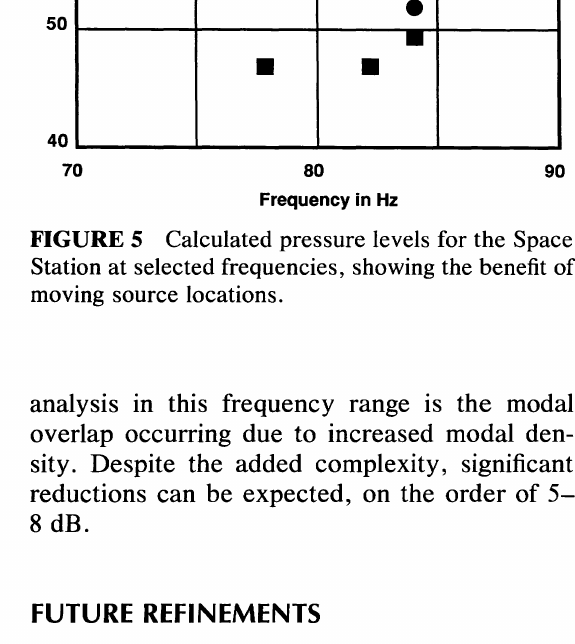
FIGURE 4 Frequencies of the first few eigenmodes for the Space Station.